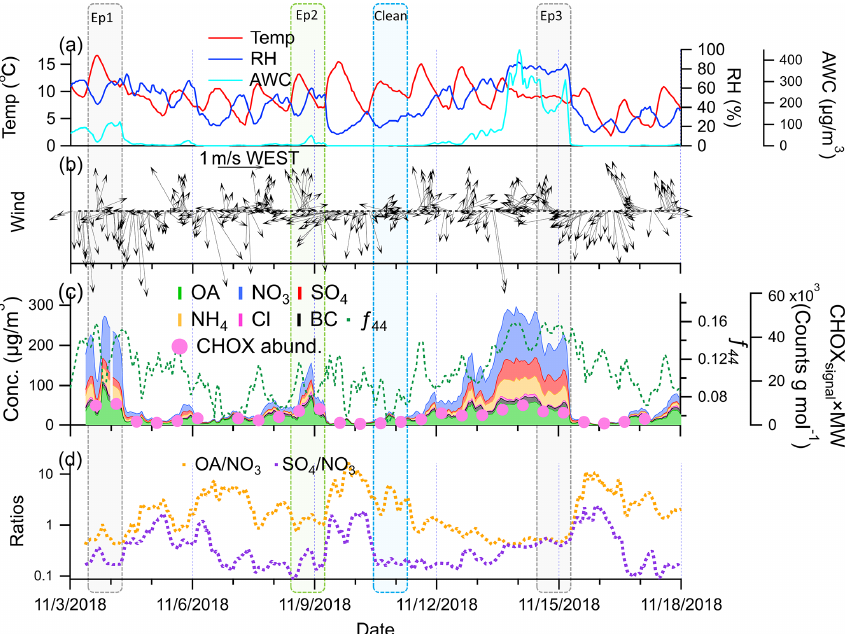
Figure 1. Time series of (a) temperature, relative humidity (RH), and aerosol water content (AWC); (b) 1h averaged wind direction and wind speed; (c) chemical components of NR-PM 2 . 5 , BC, and f 44 from the ToF-ACSM – CHO X abundance from the FIGAERO–CIMS and their sampling dates are marked by pink dots; and (d) OA / NO 3 and SO 4 / NO 3 . The sampling time of episode days is marked by boxes, which last from 09:30 to 09:00 the next day (Beijing time, UTC + 8. The date is given in the format